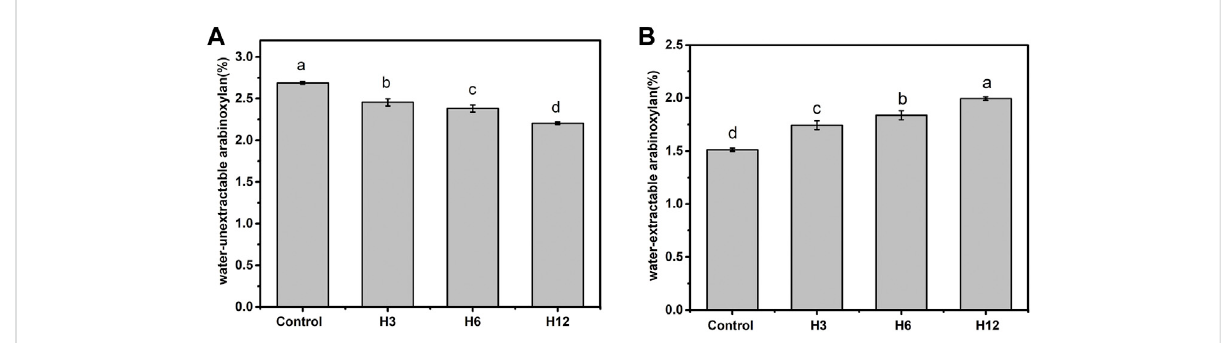
FIGURE 4 The content of wheat arabinoxylan in dough with the Hmxyn treatment. (A) Content of water-extractable arabinoxylan. (B) Content of water- unextractablearabinoxylan.Differentlettersinthesamecolumnrepresentsigni fi cantdifferences( p <